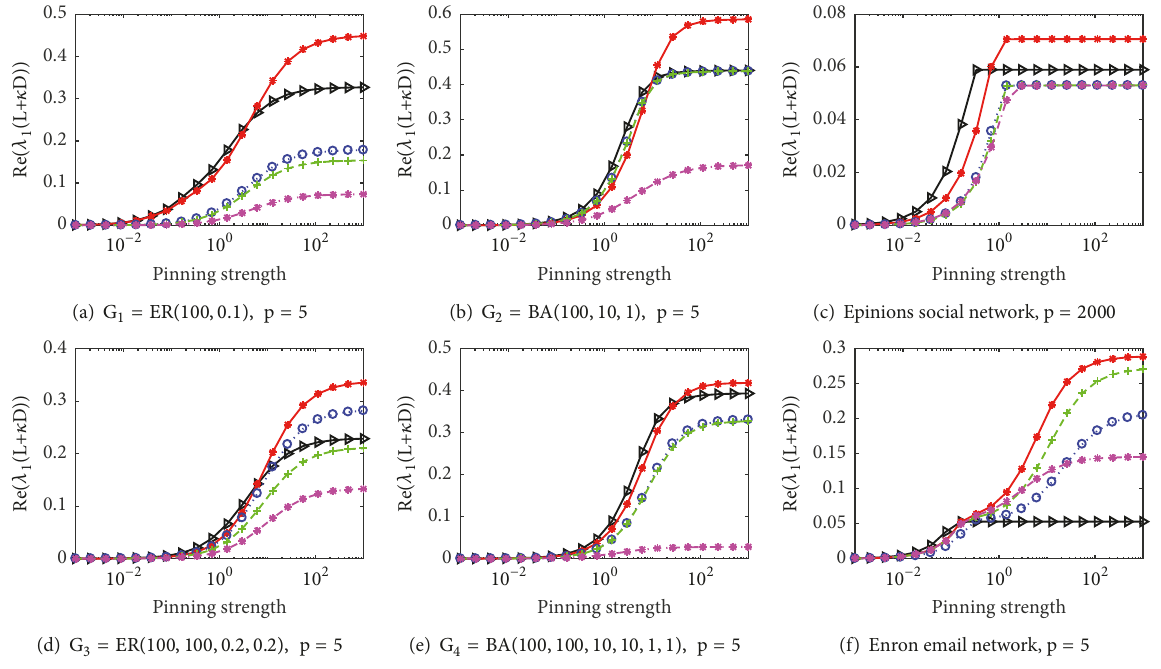
Figure 6: Variation of Re (𝜆 1 (𝐿 + 𝜅𝐷)) with respect to pinning strength. The solid red curve represents Algorithm 2, the dotted blue curve represents the outdegree centrality algorithm, the dashed green curve represents the hub centrality algorithm, and the dashed purple curve represents random algorithm. In (a), (b), and (c), the solid black curve represents the left eigenvector index pinning algorithm, whereas in (d), (e), and (f), it represents Algorithm